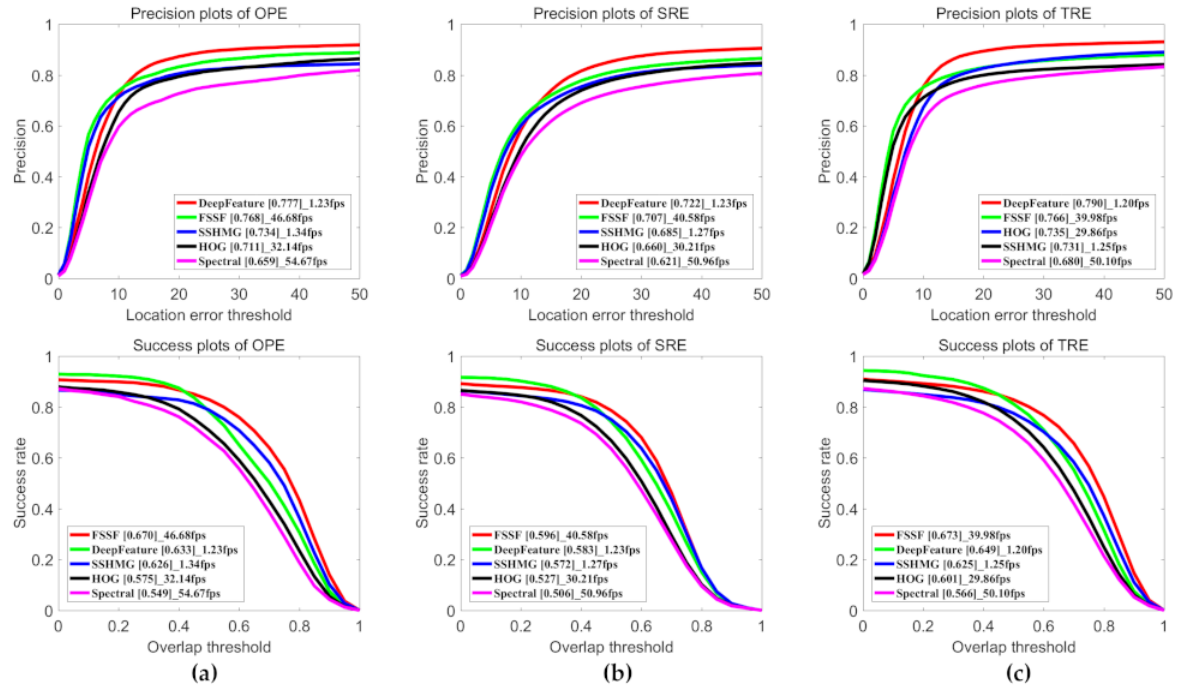
Figure 16. Precision and success plot of different features on a HSSV dataset using three initialization strategies: one-pass evaluation (OPE), temporal robustness evaluation (TRE) and spatial robustness evaluation (SRE). ( a ) Precision plot and the success plot on OPE. ( b ) Precision plot and the success plot on SRE. ( c ) Precision plot and the success plot on TRE. The legend of precision plots and success plots report the precision scores at a threshold of 20 pixels and area-under-the-curve scores, respectively. The fps of trackers in three initialization strategies is also shown in legend. Table 4. Mean DP (MDP) and mean OP (MOP) in different threshold and fps of FSSF versus DeepFeature. MDP (20) denotes the mean DP (% at pixel distance <20). MOP (0.5) denotes the mean OP (% at IOU > 0.5). Attribute